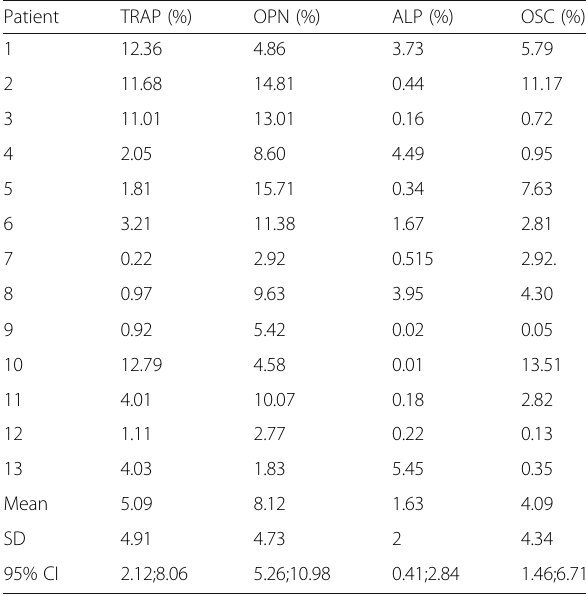
Table 3 Immunohistochemical markers proportions (i.e., TRAP, OPN, ALP, and OSC)